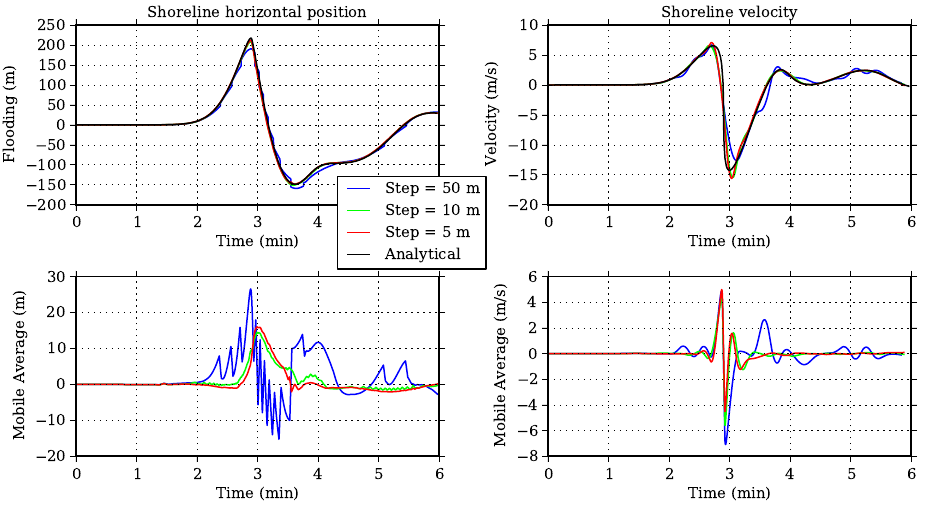
Fig. 6. Benchmark n. 1: coastline position (upper left) and velocity (upper right) predicted by UBO-TSUFD compared to the analytical solution. Residuals, i.e. differences between analytical and numerical values, are shown for coastline position (bottom left) and velocity (bottom right). Residuals have been calculated by means of a moving average over a time interval of 2.0s.